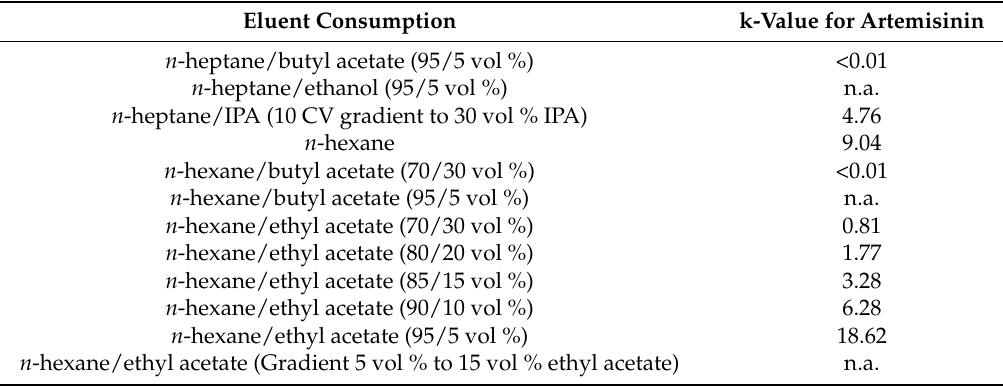
Table 4. Eluent composition for the LiChrospher Si60 column; n.a, not applicable.